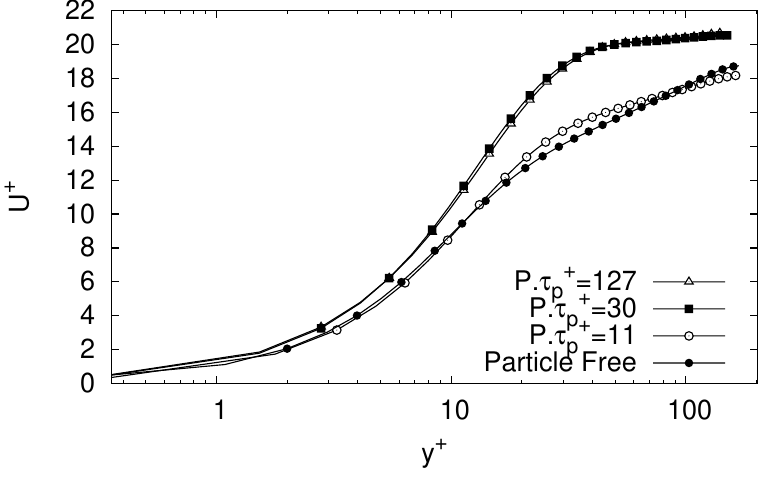
Figure 6. Mean fluid velocity profiles obtained in production cases: LMF, τ + p = 11; MMF, τ + p = 30; and HMF, τ + p = 127. PF: Particle-free case. Flow at Re τ =